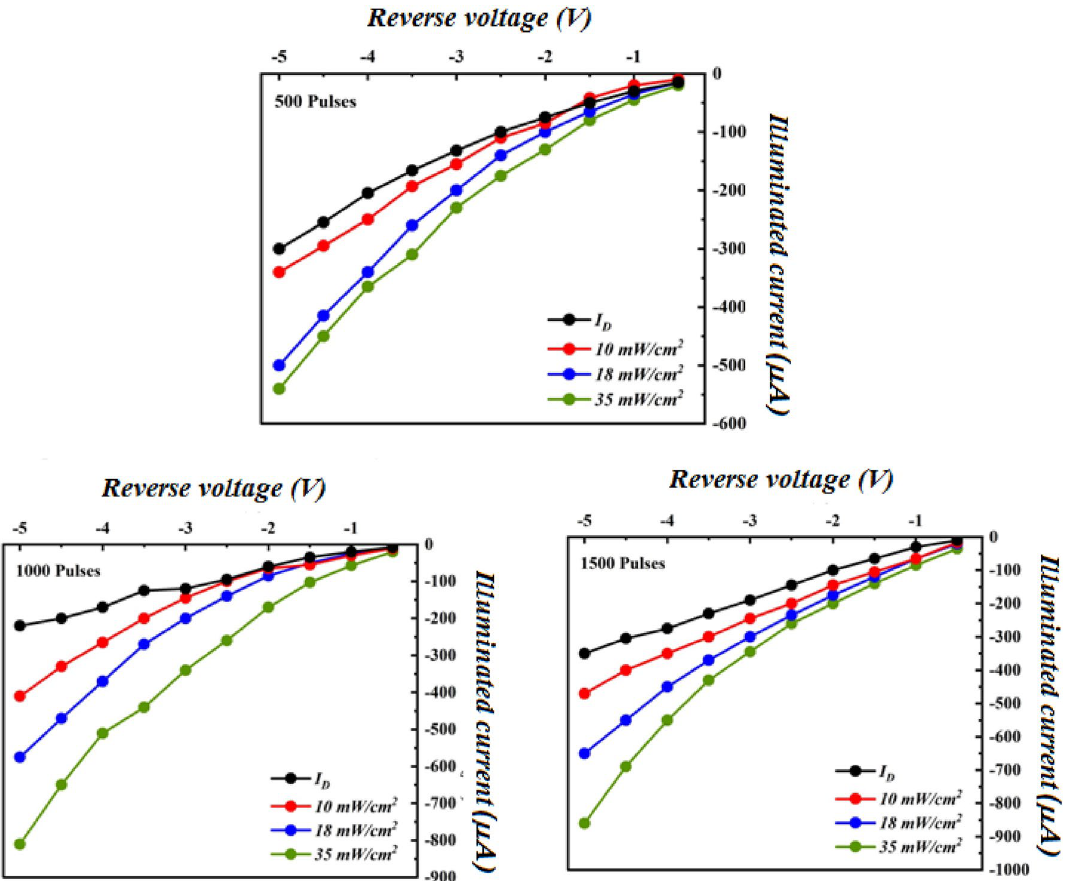
Figure 14. Dark and illuminated I–V characteristic of B 4 C/Si heterojunction photodetectors at various white light intensities synthesized with different number of laser